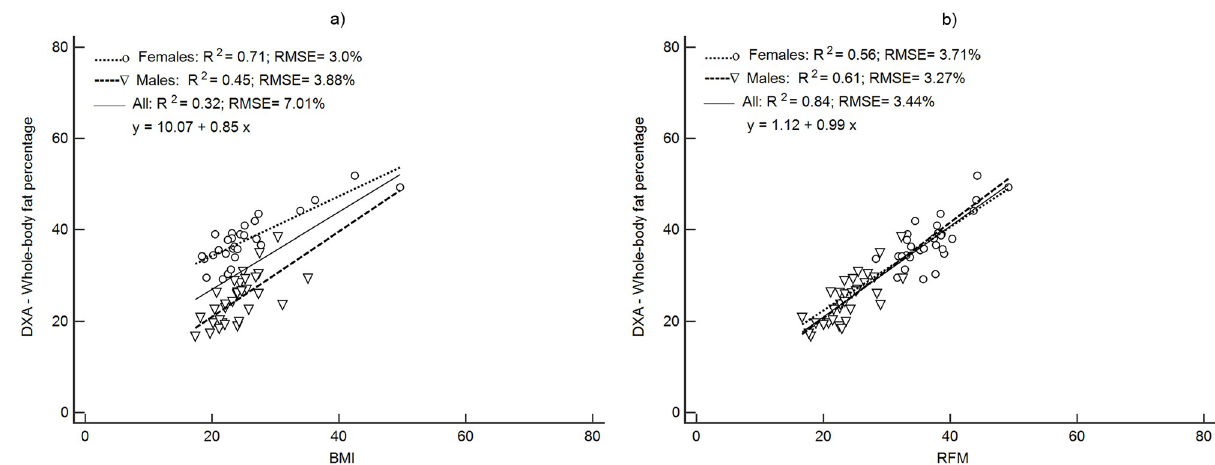
Fig 1. Prediction of FM% from BMI and RFM using DXA as a body composition method. Abbreviations: BMI, body mass index; DXA; RFM, relative fat mass; RMSE, root mean squared error.